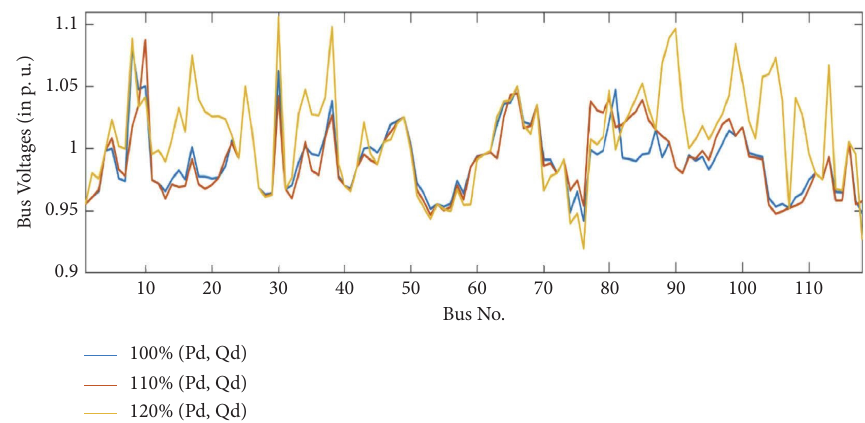
Figure 13: Bus voltage variation at diferent loadings in the IEEE-118 bus